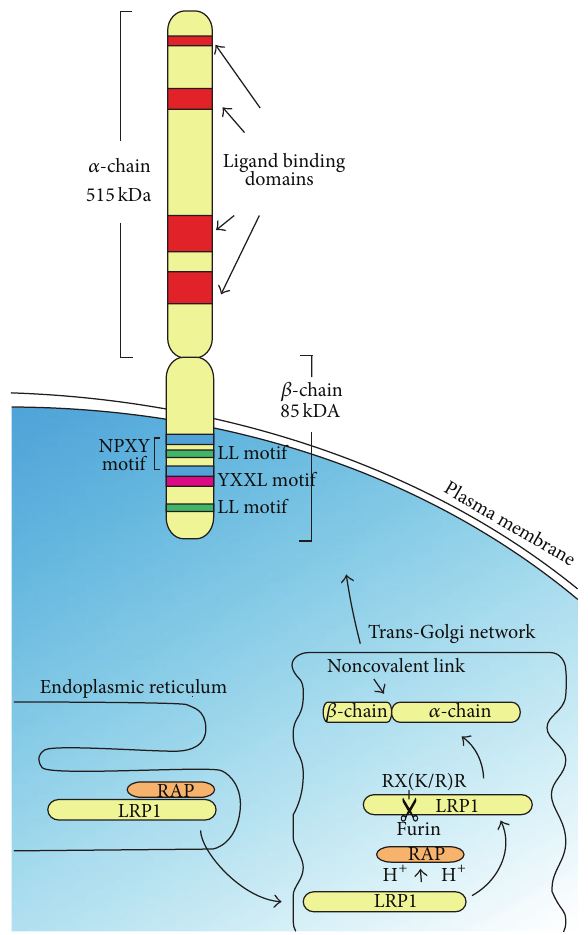
Figure 1: LRP1 maturation and structure. This schematic depicts the LRP1 precursor protein, which is synthesized in the endoplasmic reticulumandisboundtothechaperoneprotein,receptorassociated protein (RAP). The LRP1 precursor is transported to the trans-Golgi network where the low pH causes RAP to dissociate. The protease Furin cleaves the LRP1 precursor at the RX(K/R)R consensus sequence to generate a large 𝛼 -chain (515 kDa) and a smaller 𝛽 - chain (85kDa) which are noncovalently linked and shuttled to the cell membrane, where they are embedded as one functional unit. The 𝛼 -chain contains four ligand-binding domains (red) that interact with a large number of ligands. The 𝛽 -chain contains a small extracellular region, a transmembrane region which anchors the LRP1 protein within the plasma membrane, as well as two dileucine (LL, green) motifs and two asparagine-proline-x-tyrosine (NPXY, blue) motifs, where the distal motif is contiguous with a tyrosine- x-x-leucine (YXXL, pink) motif which interact with intracellular adaptor proteins and the endocytotic